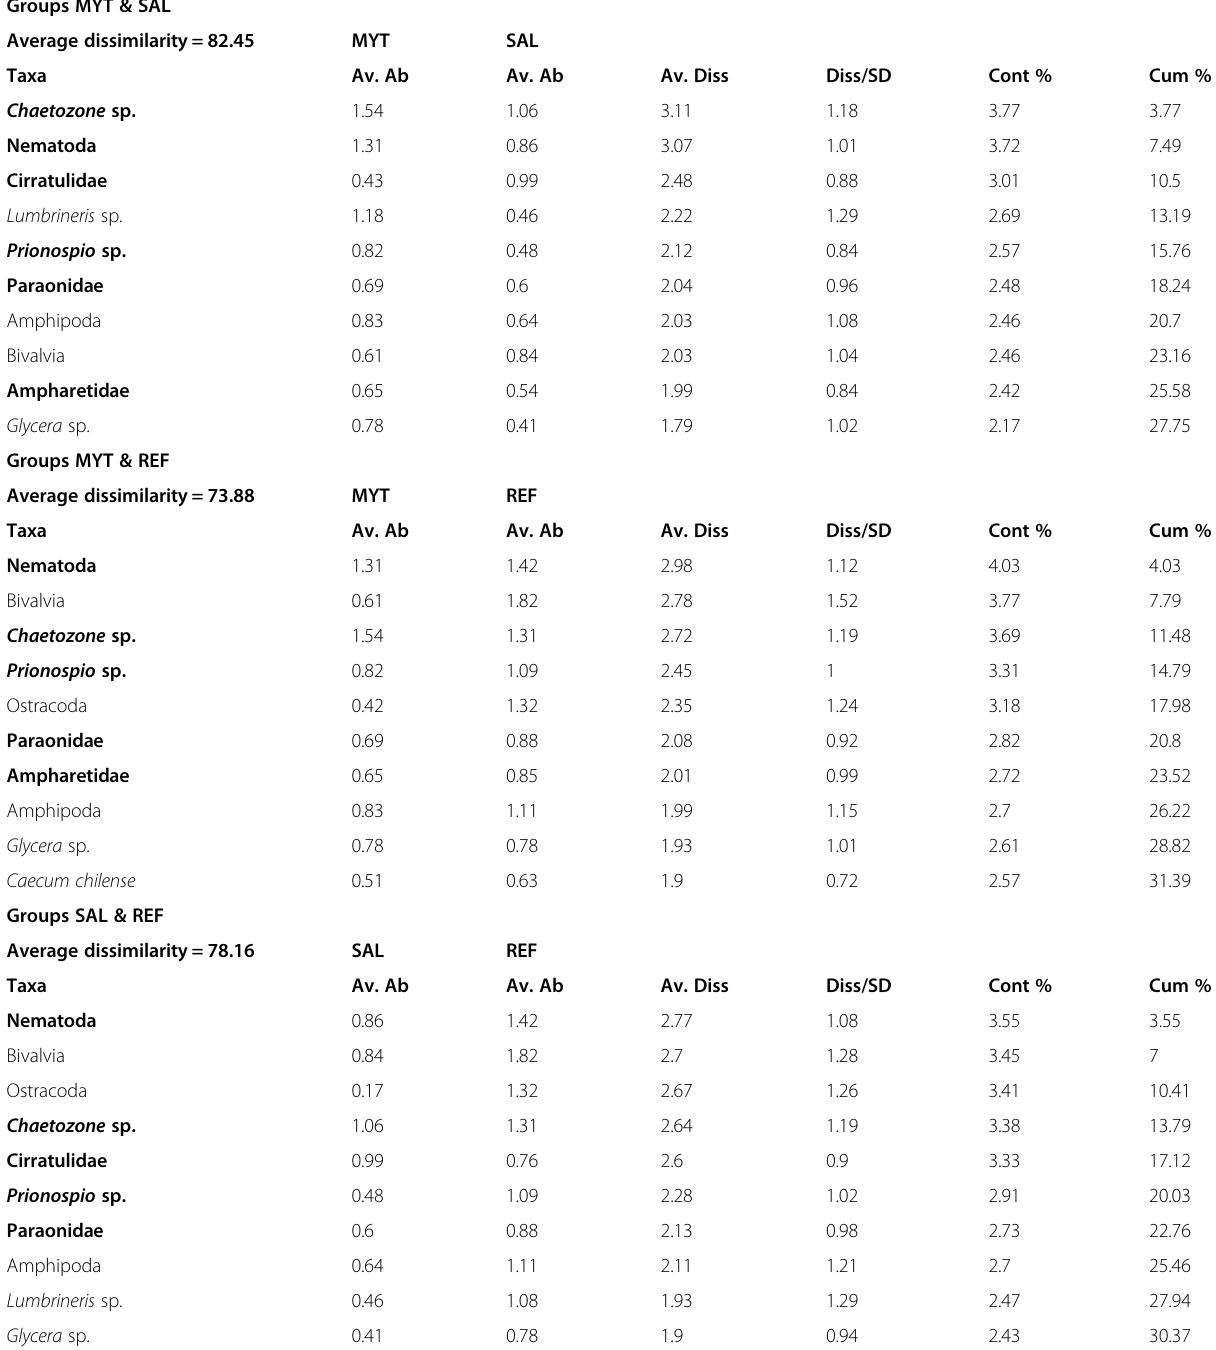
Table 8 Output of SIMPER analyses obtained from abundance species data. In bold the most representative taxa for dissimilarity among groups (MYT, SAL, REF sites) Groups MYT & SAL Average dissimilarity=